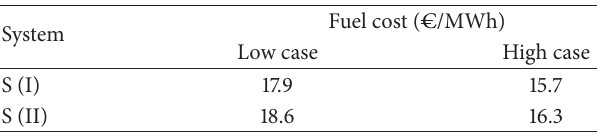
Table 4: Effects on fuel cost (C/MWh) of changing storage outcome from a low to a high case by simultaneously changing all related parameters (moisture content, ash content, and dry matter losses) in systems (I) and